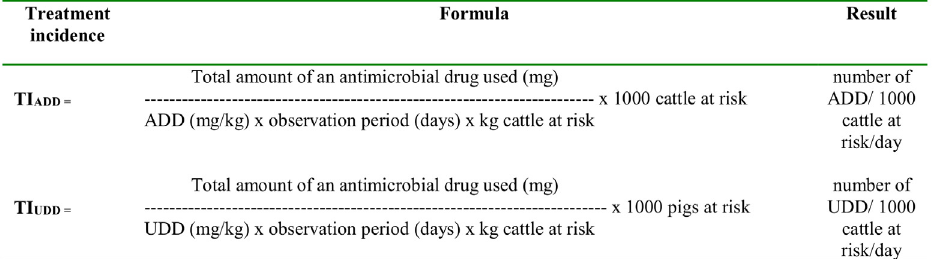
Fig 1. Formulae for the calculation of the treatment incidence (TI) based on the animal defined daily dose (ADD; TI ADD ) and used daily dose (UDD; TI UDD